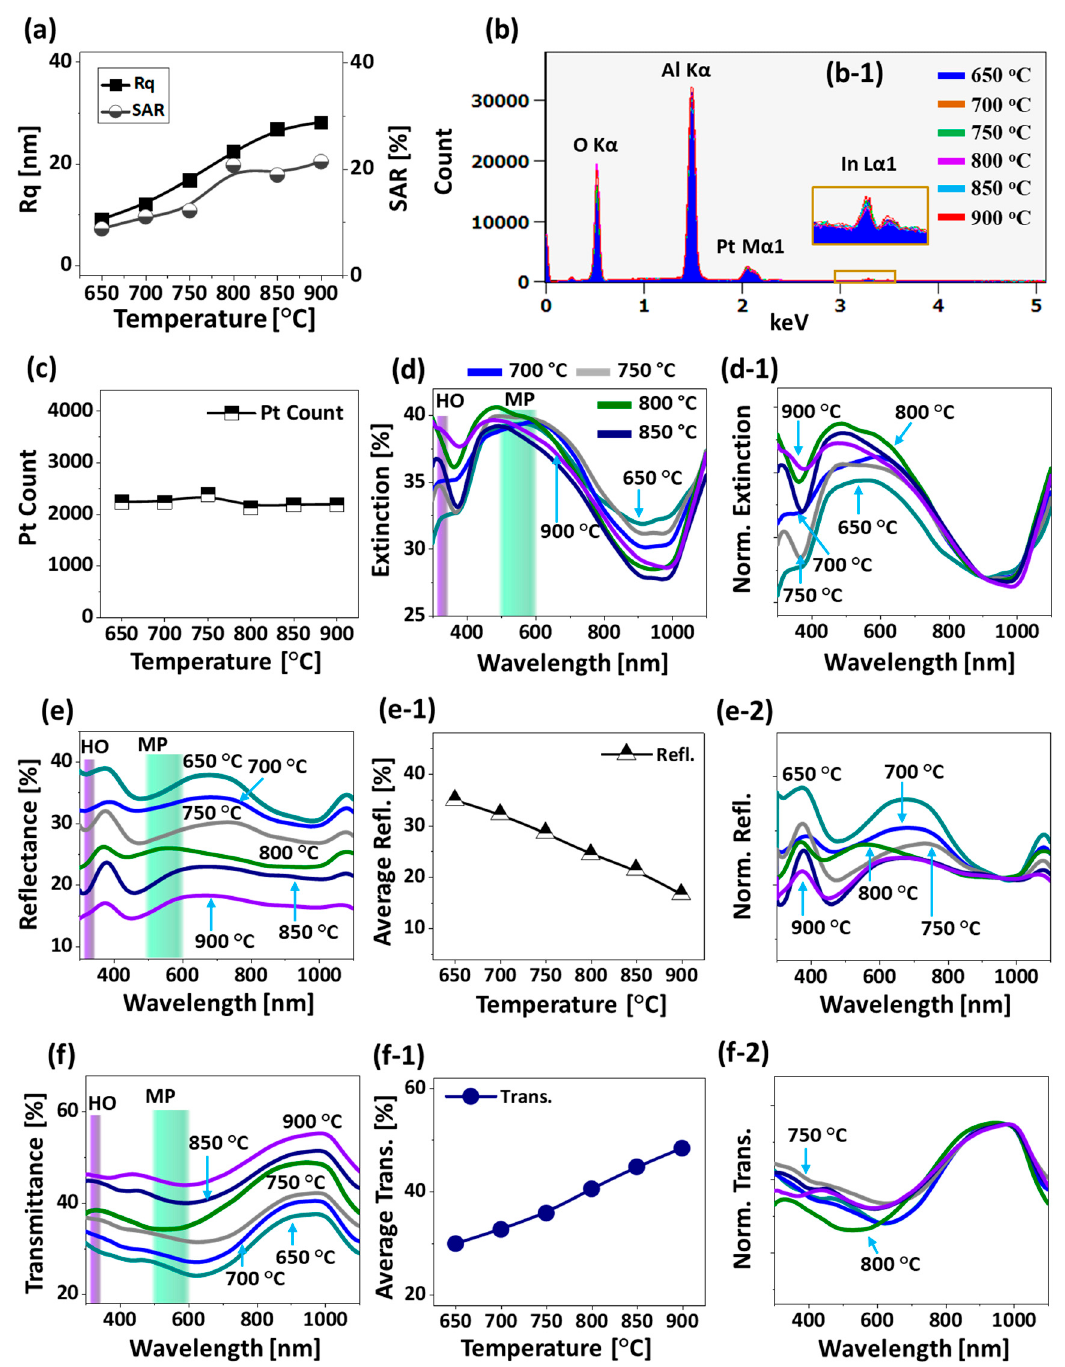
Figure 6. Morphological, elemental and optical summaries of Pt NPs with the In 45 nm / Pt 15 nm bilayers. ( a ) Summary plots of Rq and SAR. ( b ) EDS spectra of Pt NPs. ( b-1 ) (Inset) Enlarged In peak at ~3.2 keV. ( c ) Pt count at different temperatures. ( d )–( d-1 ) Extinction and normalized spectra. ( e )–( e-2 ) Reflectance, average reflectance plot and normalized spectra. ( f )–( f-2 ) Transmittance spectra, average transmittance plot and normalized spectra.